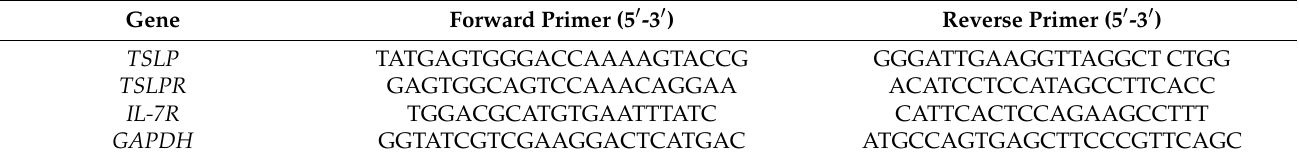
Table 1. Primers used for quantitative